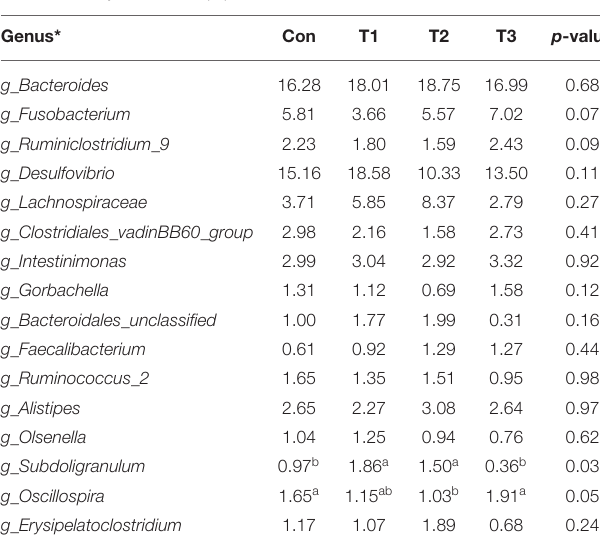
TABLE 9 | Genus-level relative abundances of fecal microbiota in ducks with different dietary treatments